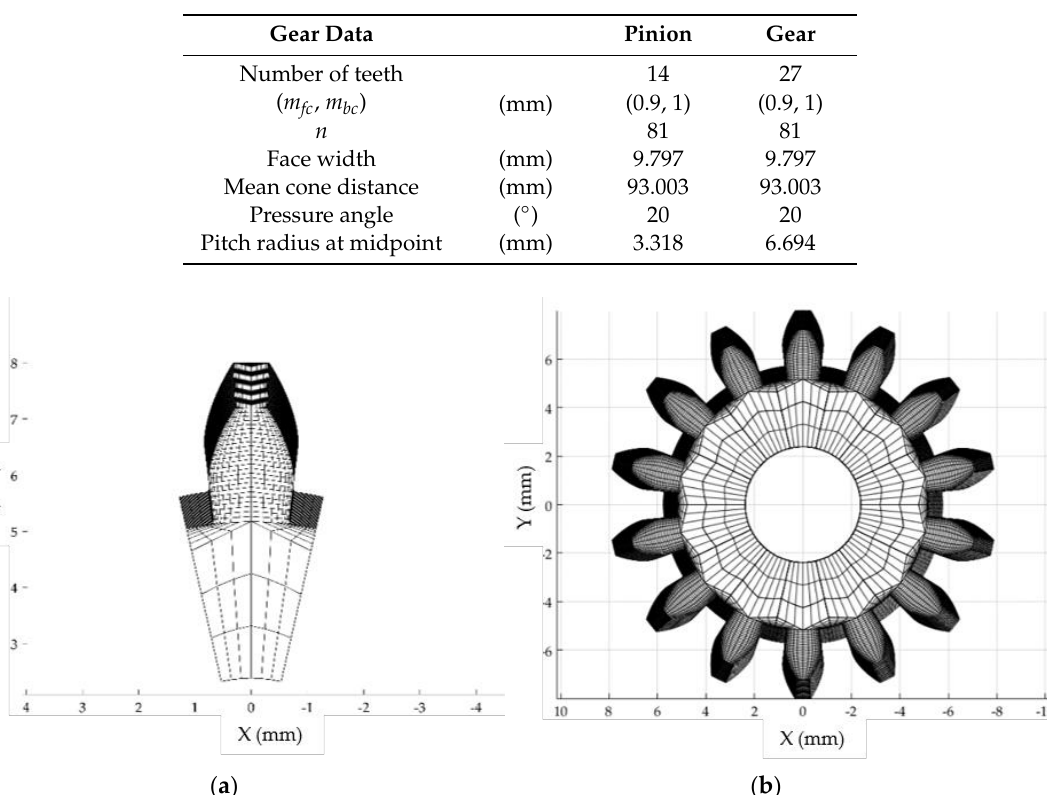
Table 1. Blank data of the example bevel gear pair.